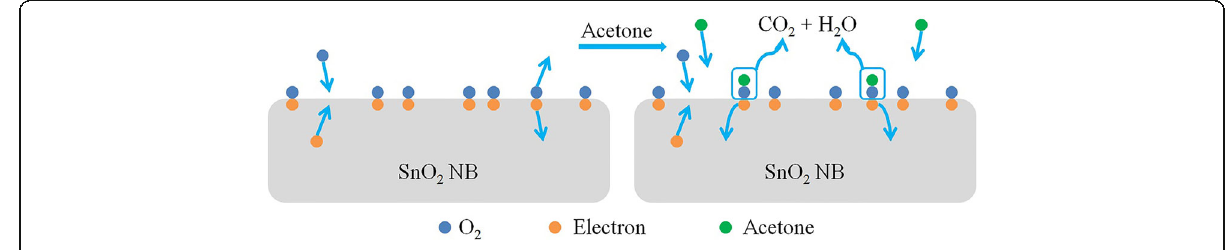
Fig. 9 The schematic diagram of gas-sensing